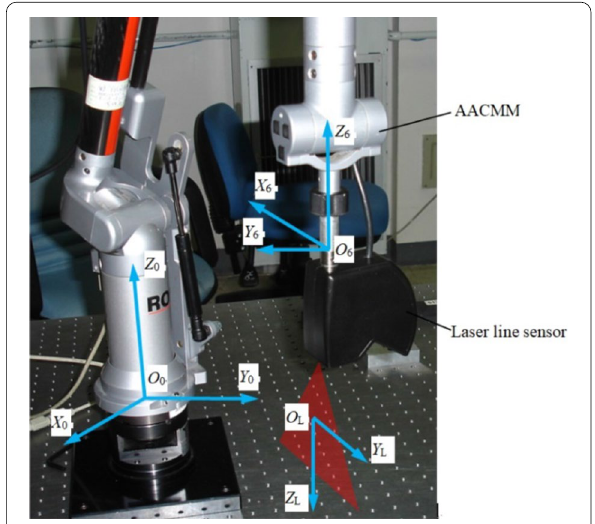
Figure 1 The integrated system of an AACMM and a laser line